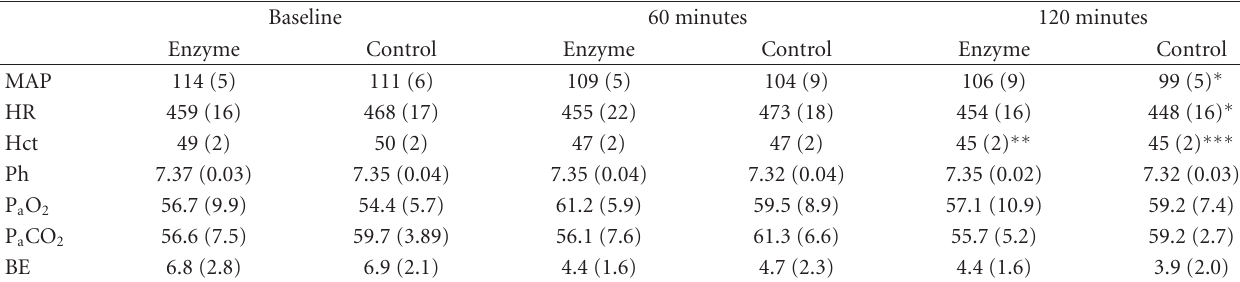
Table 1: Hemodymanical parameters and hematology.